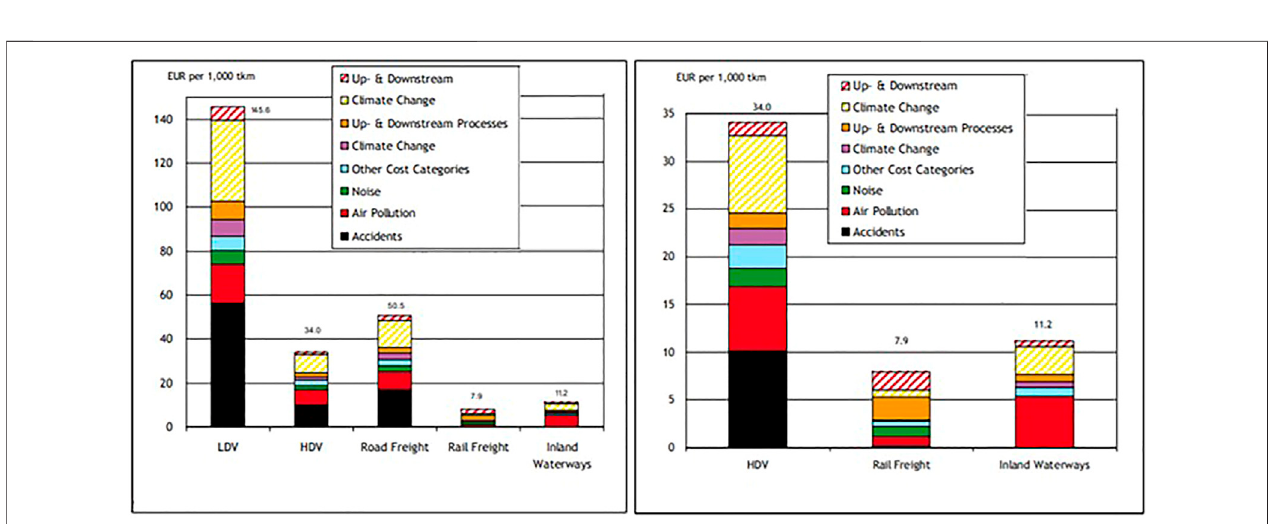
FIGURE3| Monetisedexternalities ofvarious forms ofgoods transport intheEU in2008 (Left) and acomparison ofthemonetisedexternalitiesofHDVswithother modes (Right) (Van Essen et al., 2011).